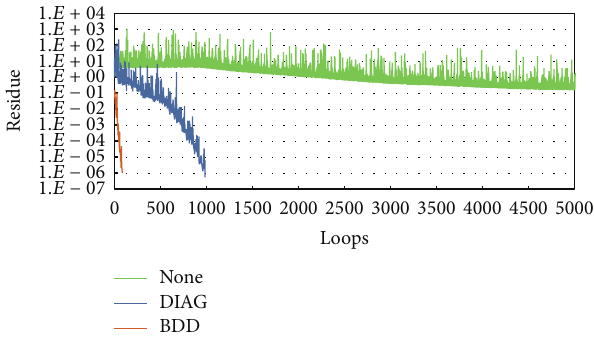
Figure 3: Convergence comparison.